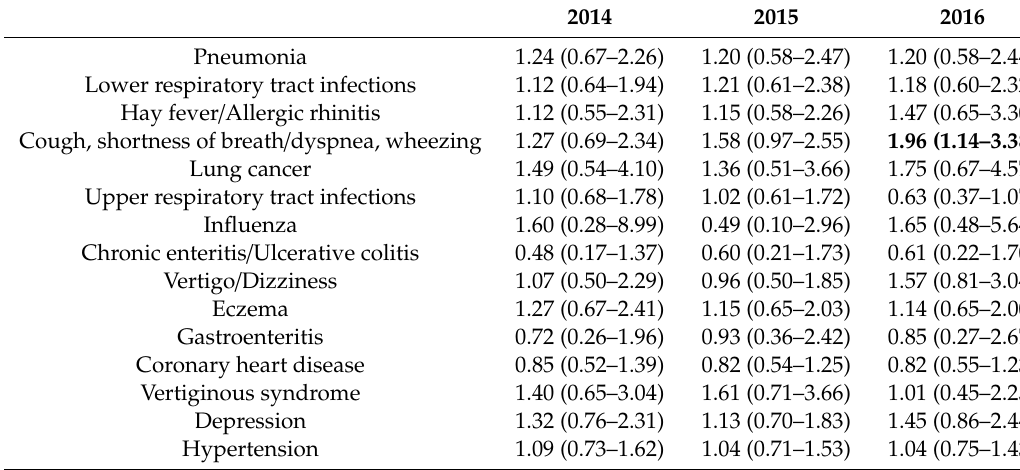
Table A16. Di ff erences (OR, 99% CI) a per year in various comorbid conditions between the livestock dense areas and control areas among ACOS patients b (statistically significant results in bold)